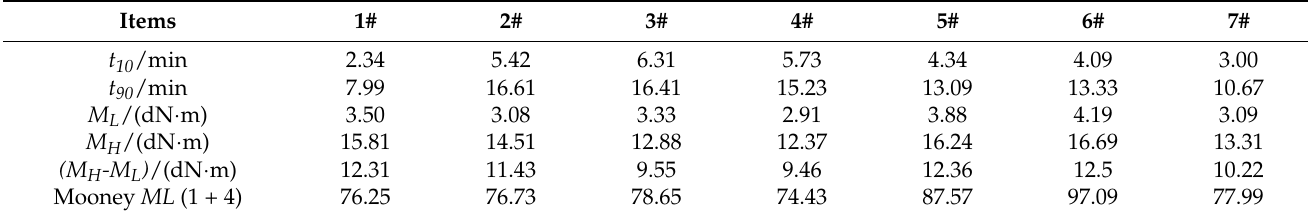
Table 2. Results data of experiments for vulcanizate properties without